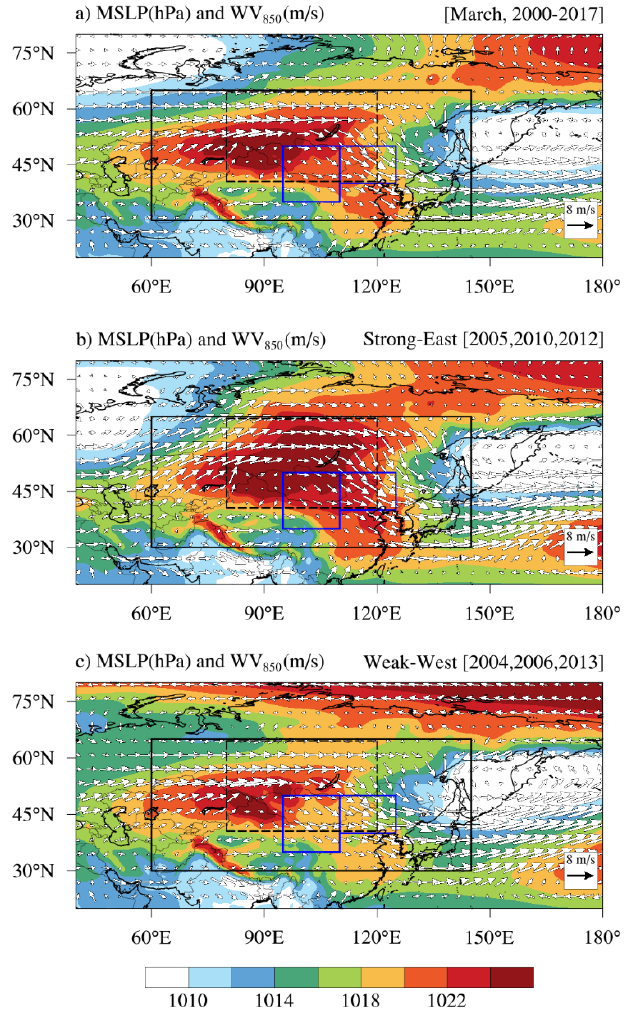
Figure 4. Composite maps of MSLP (shaded; unit: hPa) and WV 850 (white arrows; unit: m s − 1 ) for March in ( a ) 2000–2017, and ( b ) the Strong-East (average of 2005, 2010, 2012) and ( c ) Weak-West (average of 2004, 2006, 2013) periods. The arrow in the lower right corner denotes wind speed of 8 m s − 1 . Contour interval is at 2 hPa. Boxes are the same as shown in Figure 1. There are apparent differences in SHI and SHPI between the Strong-East and Weak- West periods. In the Strong-East period, the maximum value of the SHI was greater than 1027 hPa, locating within the range 45°–52.5° N and 85°–98° E. The averaged SHPI was 99.1° E, shifted approximately 10° eastward of the 18-year climatological SHPI (90.46° E).